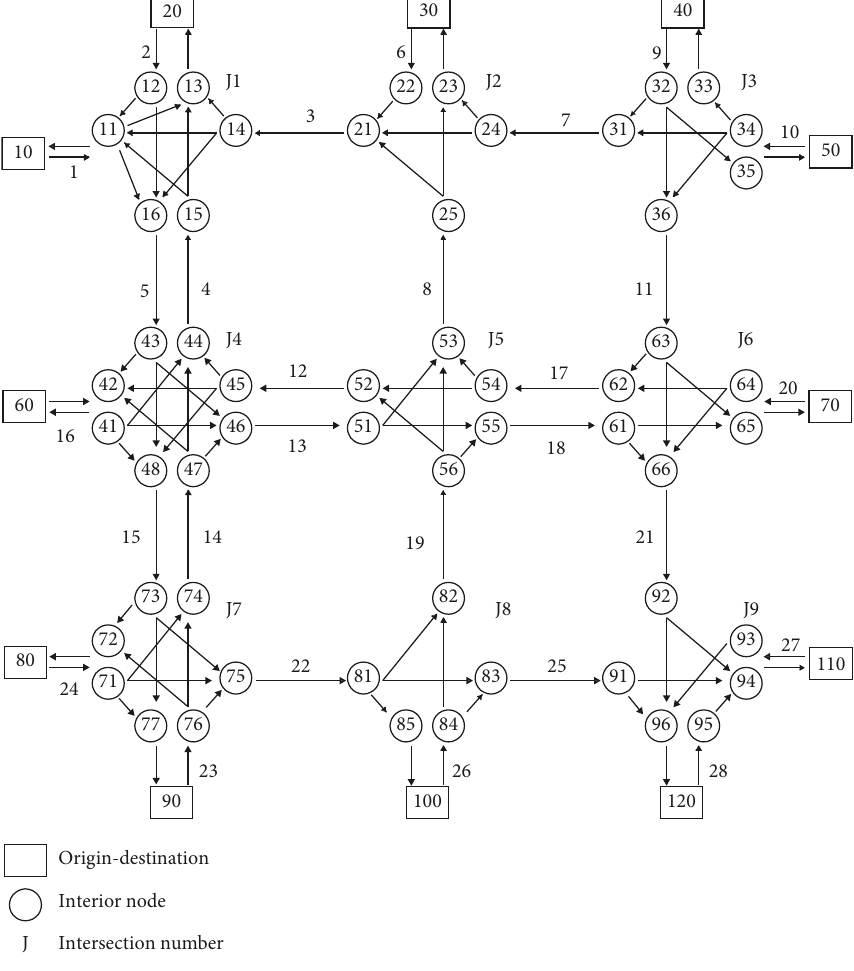
Figure 6: Test Network-2 and its representation for the PFE